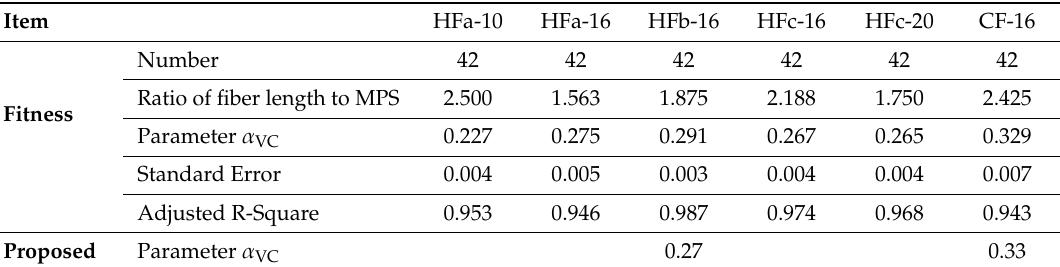
Table 5. Statistical results of the parameter a VC .